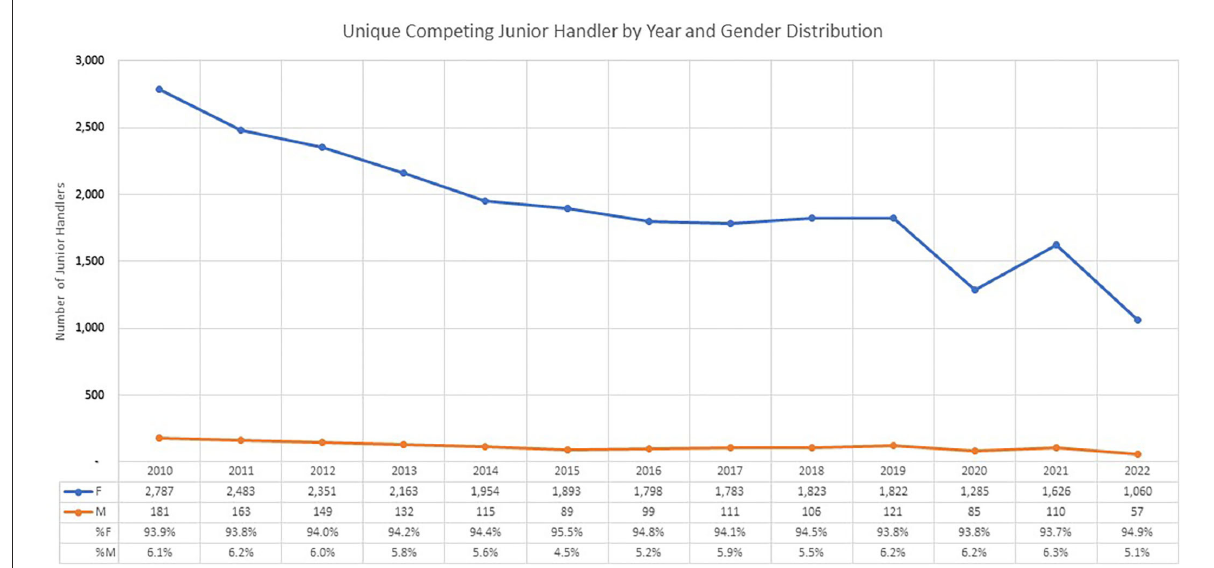
FIGURE1 Historical data from the AKC showing distribution of males (red line) and females (blue line) between 2010 and 2022. The data table represents the absolute number and relative percentage of females and males competing per year.